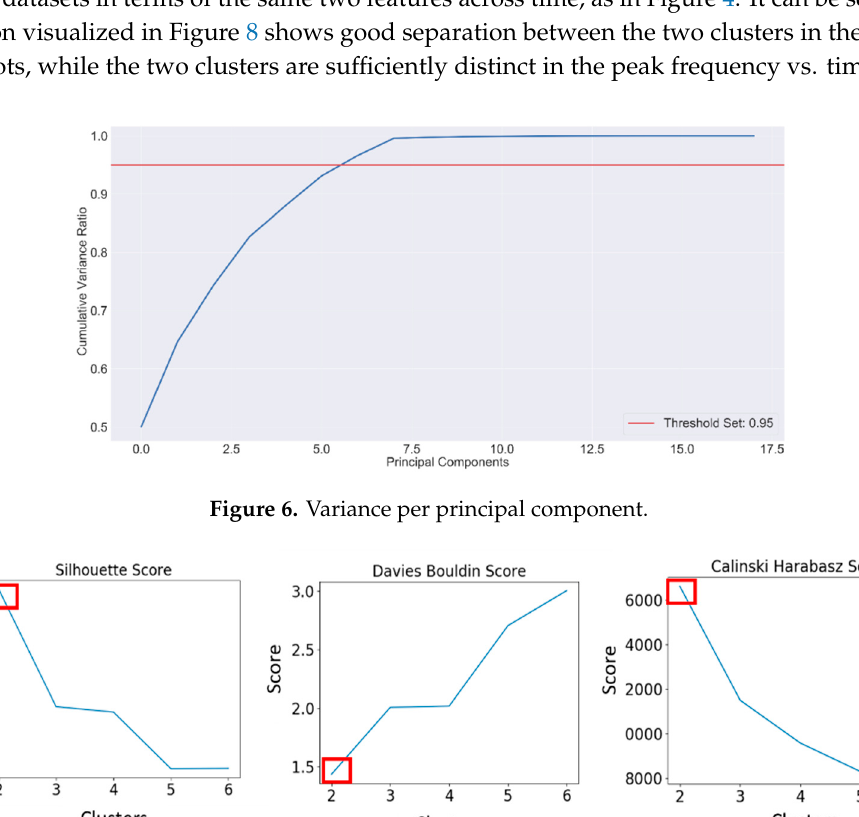
Figure 5. Pearson coefficient correlation matrix.